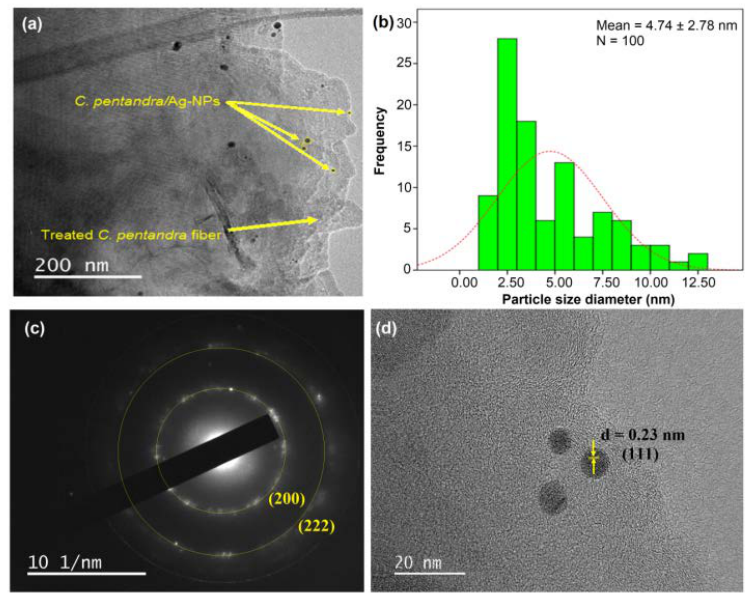
Figure 10. ( a ) FETEM image ( b ) particle size distribution histogram ( c ) SAED pattern and ( d ) latticed-spacing parameter of C. pentandra /Ag-NPs.